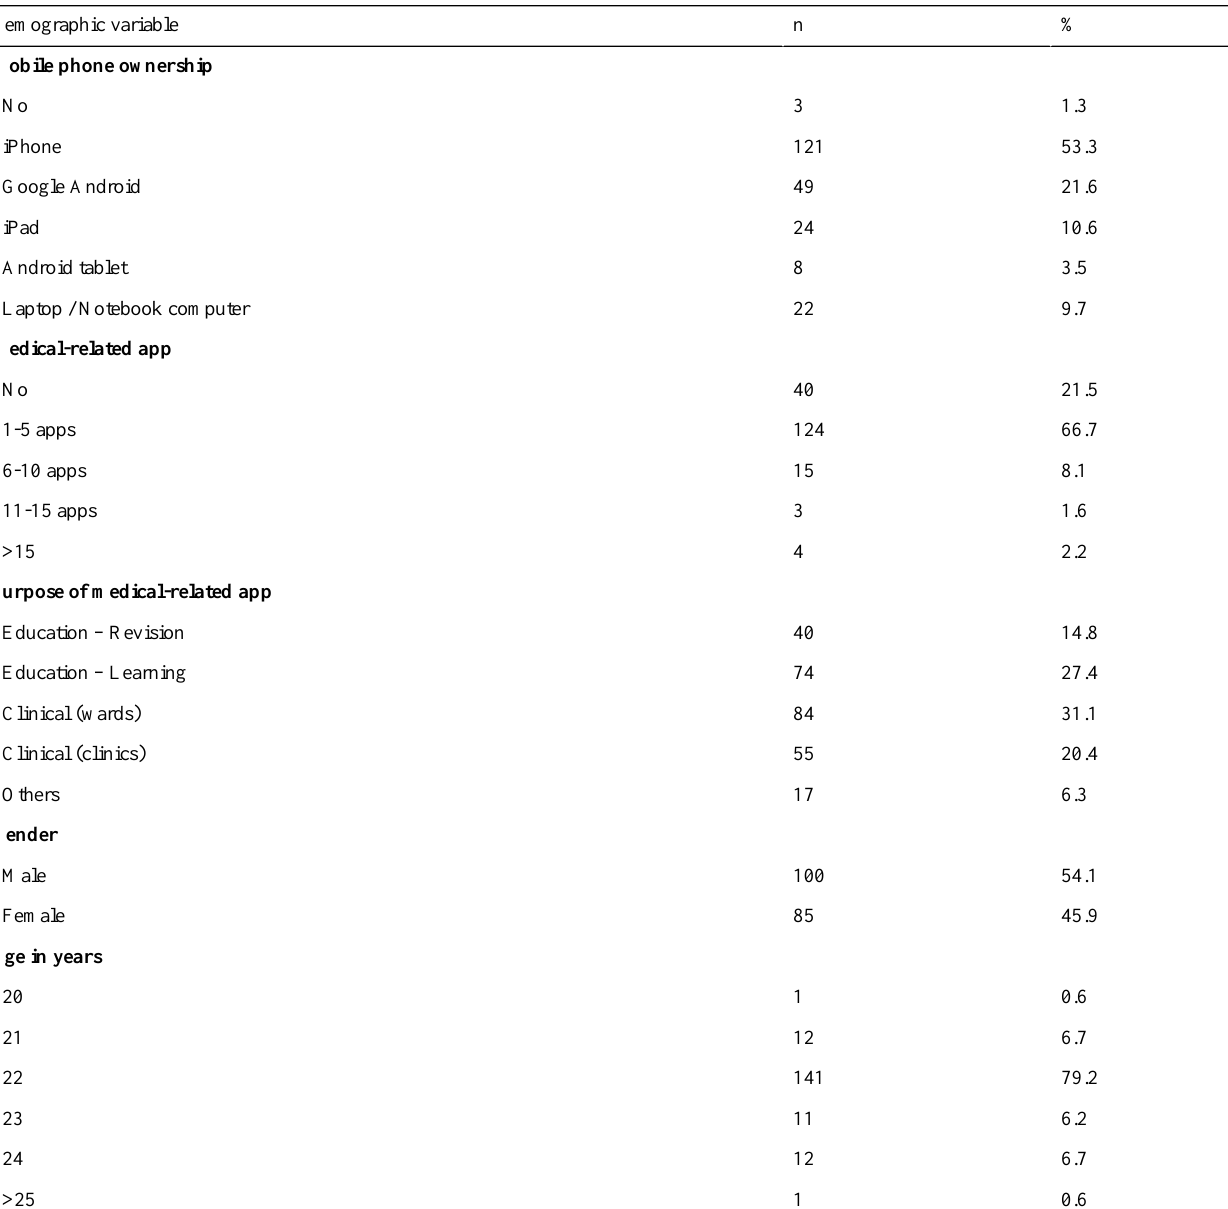
Table 1. Student’s baseline demographic